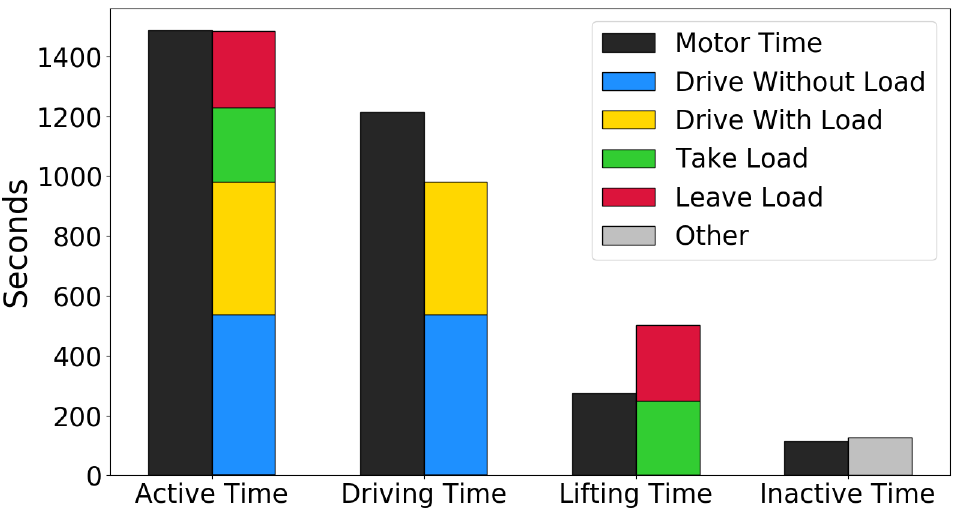
Figure 10. Predicted activities on the hold-out test set, compared to the current industry standard method (motor time) for measuring forklift